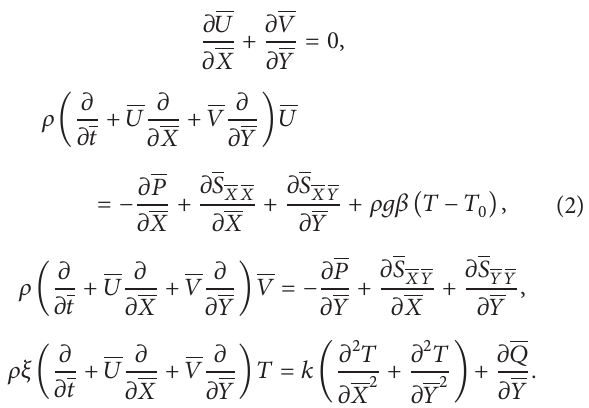
𝑑 𝜙 are related 𝑖 , 𝑖 , and 2 [17]. The radiative heat